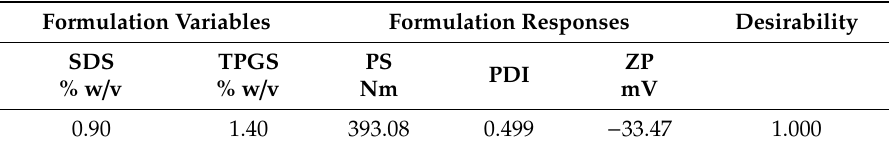
Table 7. Formulation variables and associated responses.